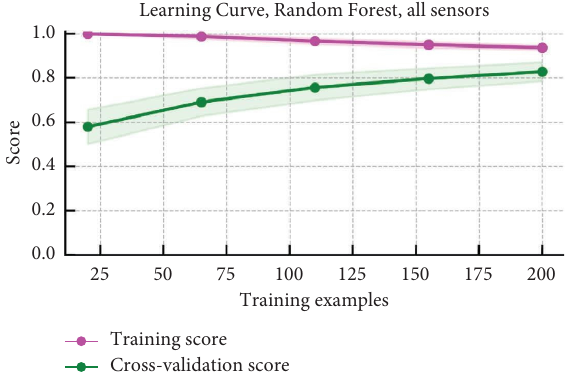
Figure 6: Learning curve for random forest